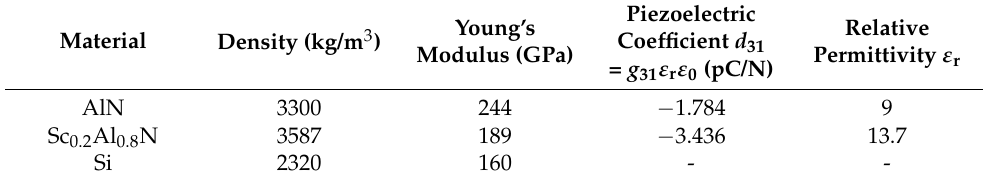
Table 2. Main parameters of the materials [26–28].